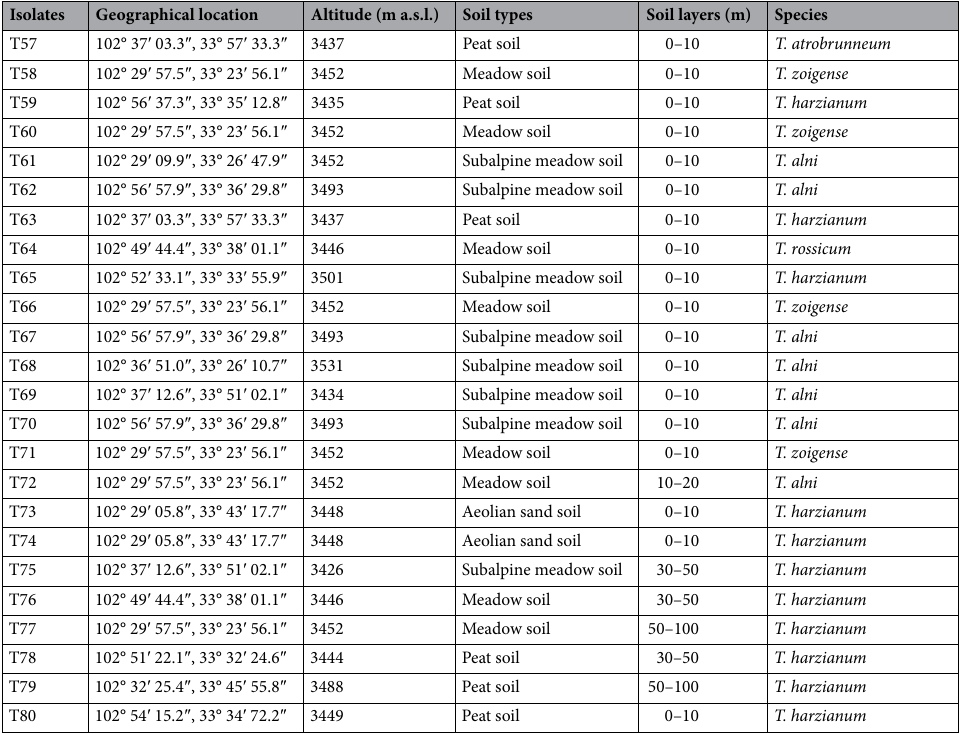
Table 1. Details of 80 Trichoderma isolates from the Zoige alpine wetland in this